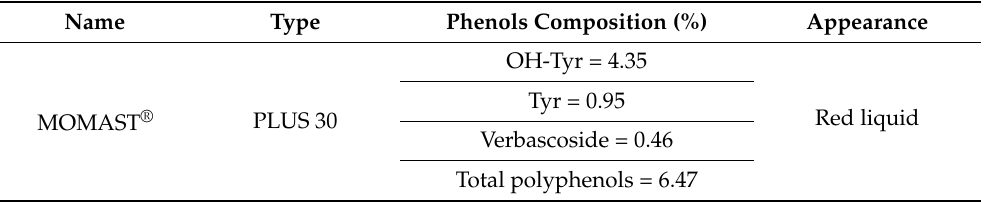
Table 1. MOMAST ® sample features and phenols